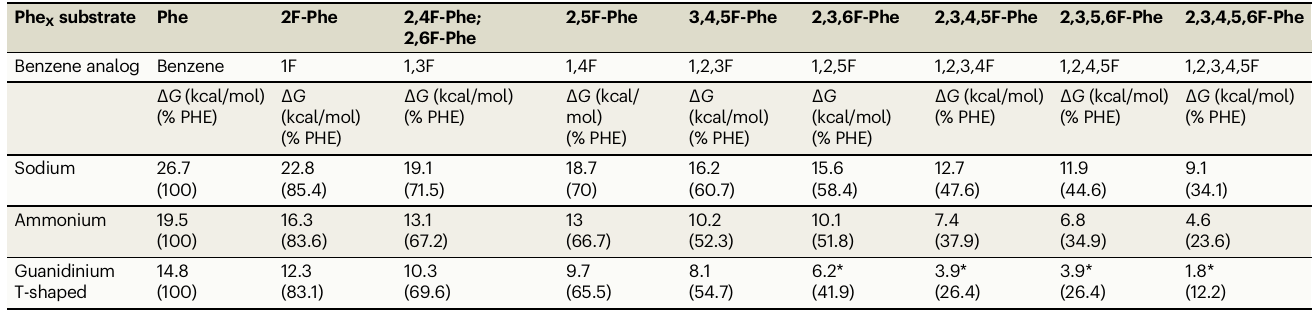
Table 1 | Effects of fl uorination on interaction energies with cations Phe X substrate